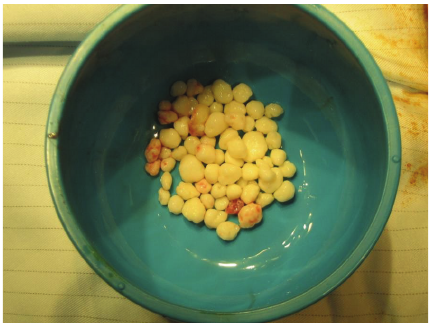
Figure 3: More than 40 retrieved loose bodies which were homoge- nous in